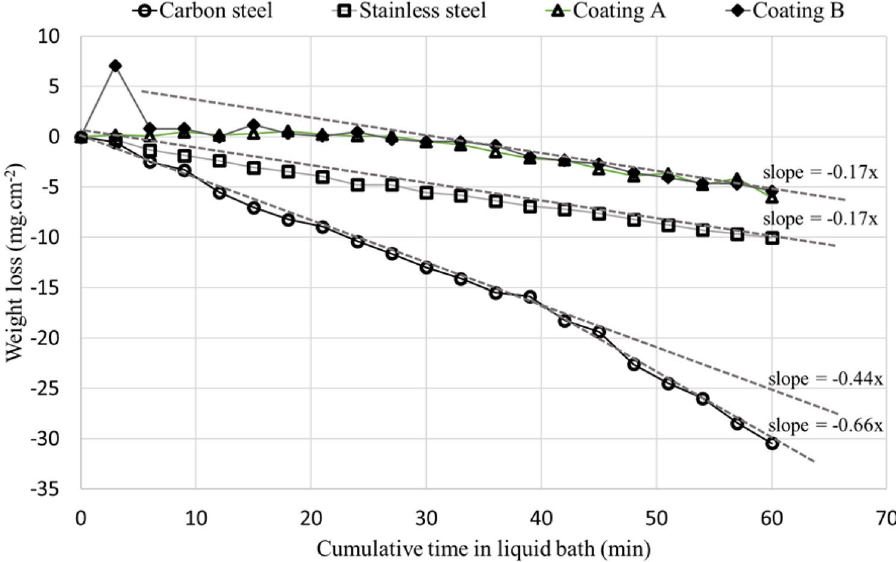
Fig. 6 Weight loss of the studied materials for 3 min galvanizing